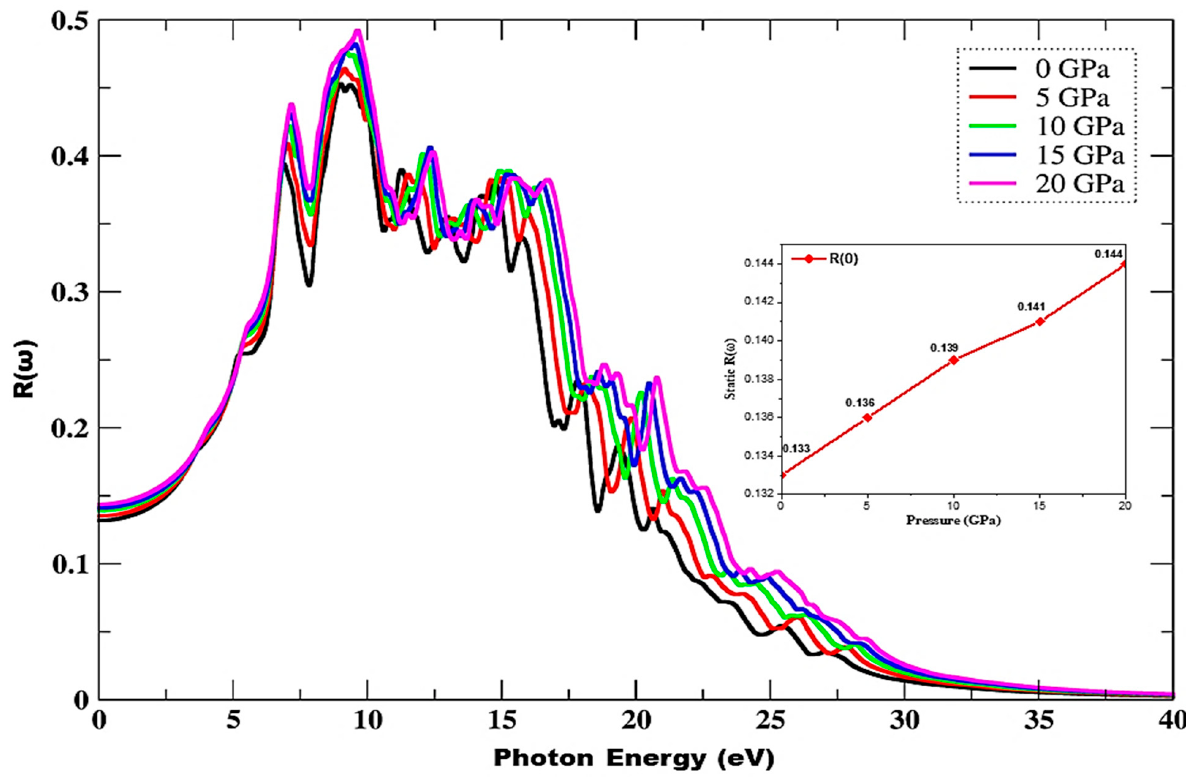
Figure 9. Pressure-influenced variations in reflectance. The inset depicts variation in static index of reflection, 𝑅(0) , under the influence of pressure.